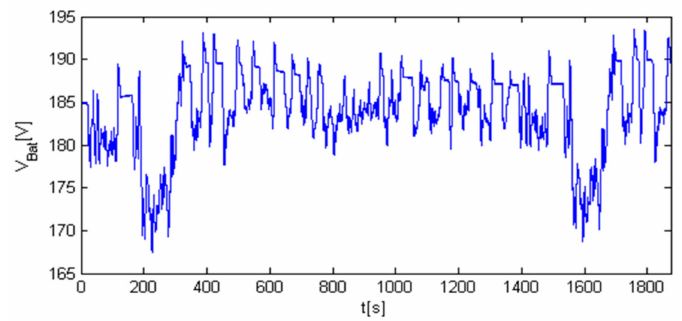
Figure 21. Batteries module terminal voltage.